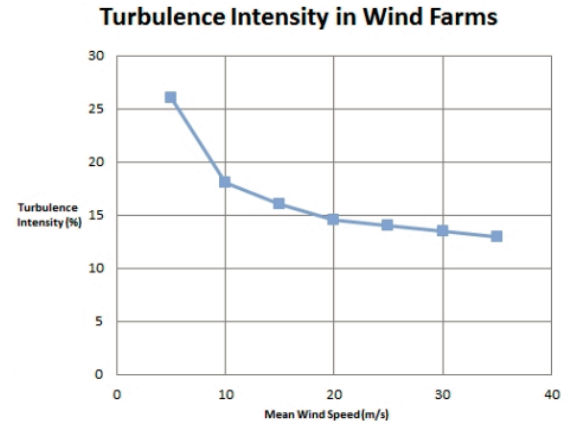
Figure 7. Mean wind speed vs. turbulence